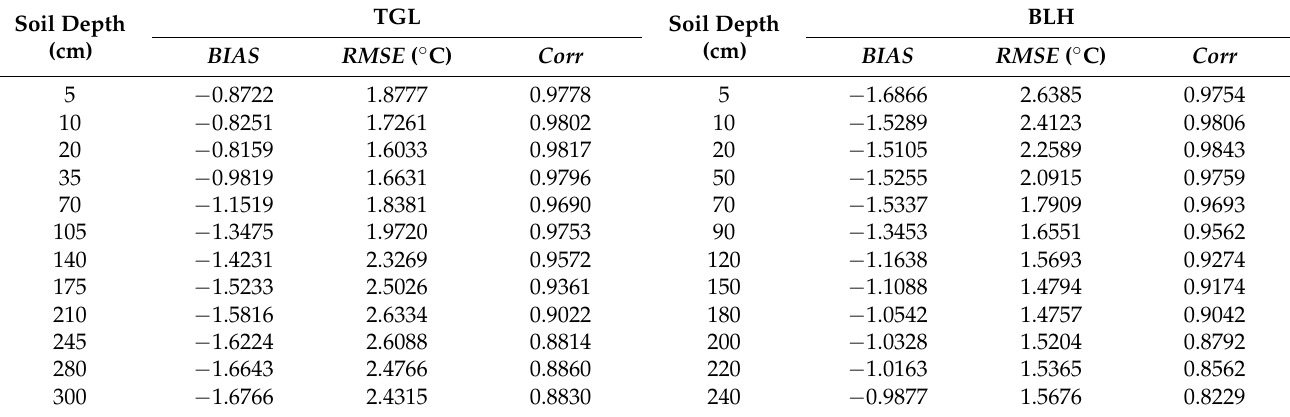
Figure 2. A comparison of the simulated and observed soil temperatures at various depths at the TGL and BLH sites.